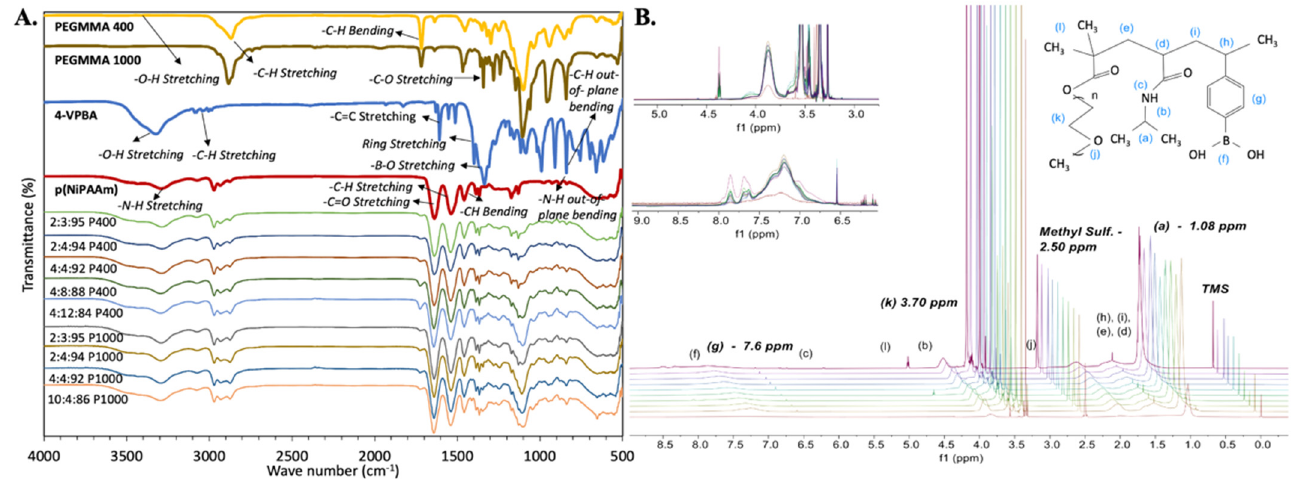
Figure 2. Terpolymer spectrometric characterization. ( A ) FT-IR spectra of synthesized terpolymers, including pNiPAAm as a baseline. ( B ) 1 H-NMR spectra with identification of all corresponding protons in the polymer, including pNiPAAm as a baseline. After pNiPAAm, synthesized terpolymers spectrum are shown from bottom to top as follows: 2:3:95, 2:4:94, 4:4:92, 4:8:88, and 4:12:84 P400 terpolymers, then 2:3:95, 2:4:94, 4:4:92, and 10:4:86 P1000 terpolymers.